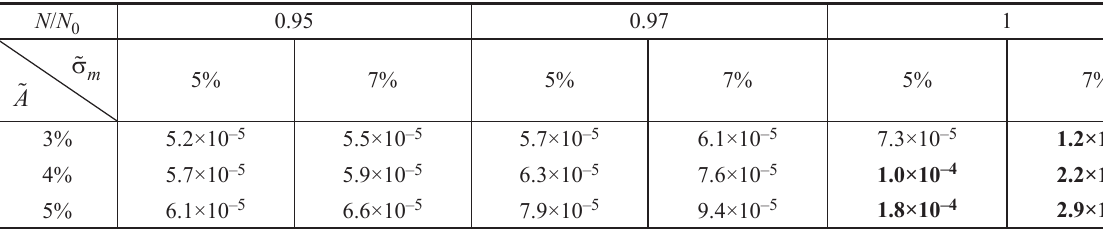
Table 3. Probability frequency distribution N = Z 1 · Z 2